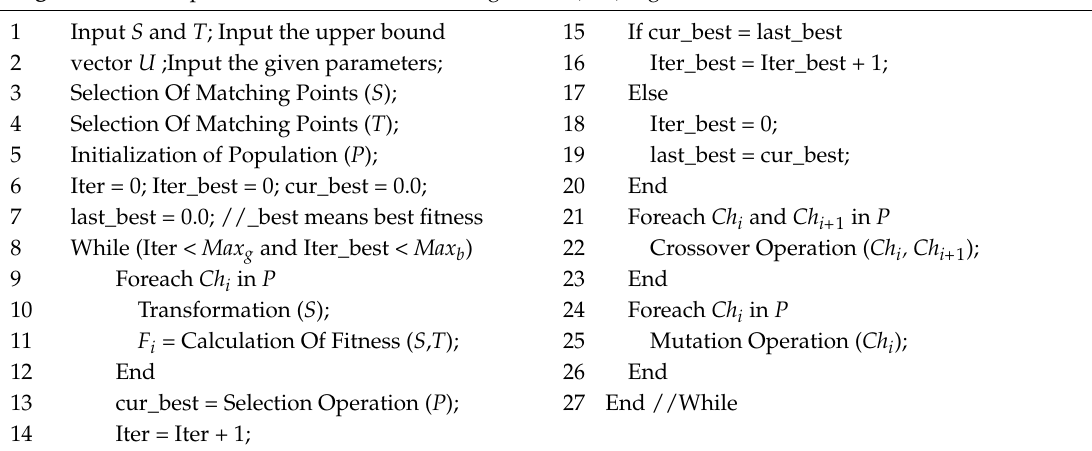
Algorithm 3. The pseudo code of the Genetic Algorithm (GA)